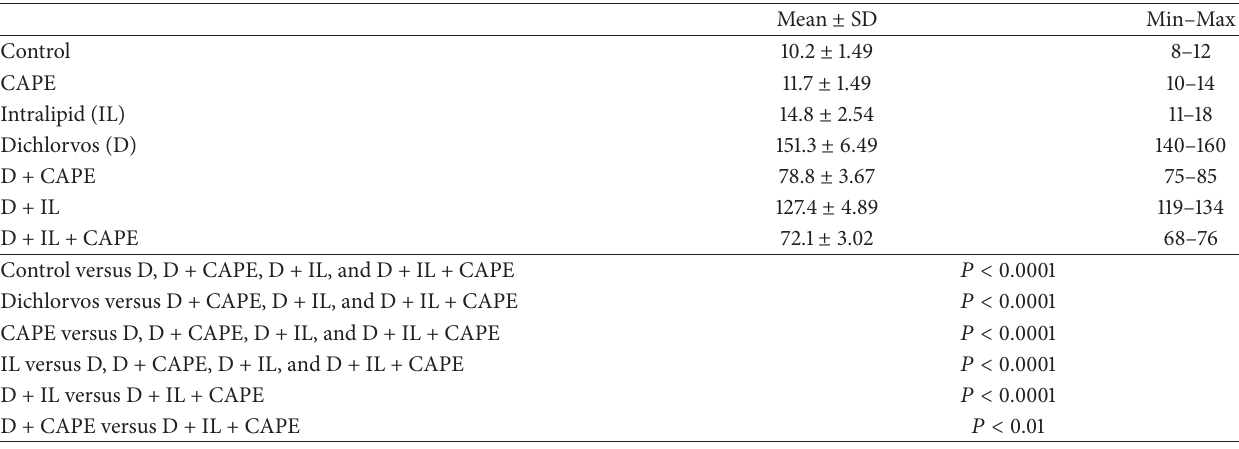
Table 3: Histopathologic results for kidney tissues, apoptotic cell count.